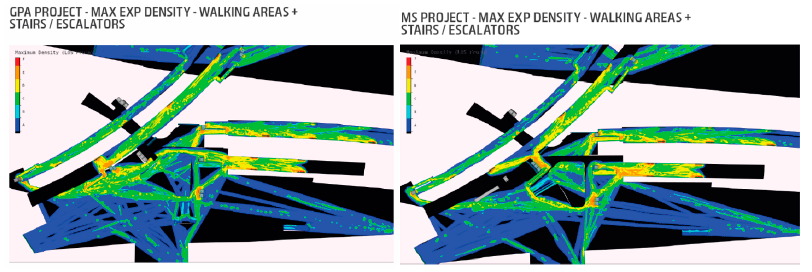
Figure 4. Flow models predicting experienced density for pedestrians. Left is GPA’s design pro- posal, and right is the preliminary design proposal by the client. and right is the preliminary design proposal by the